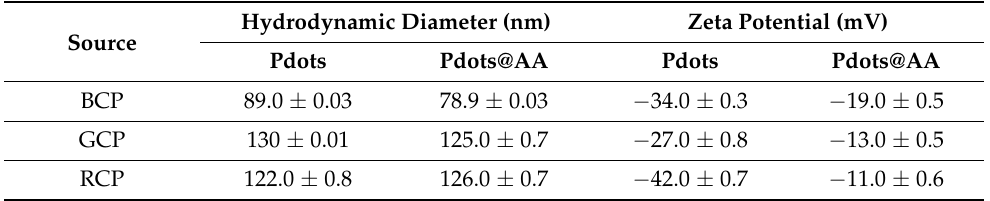
Table 2. DLS Results of Pdots and Pdots@AA.